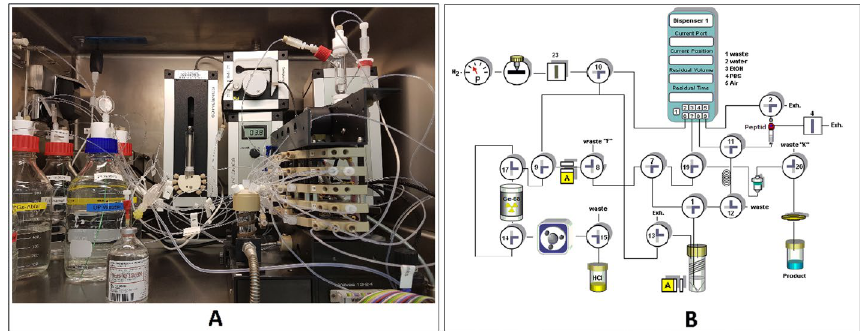
Fig. 4 A. Setup for the production of [ 68 Ga]Ga-FAPI-46 on GallElut Scintomics synthesizer, and (B) Scheme of the synthesis